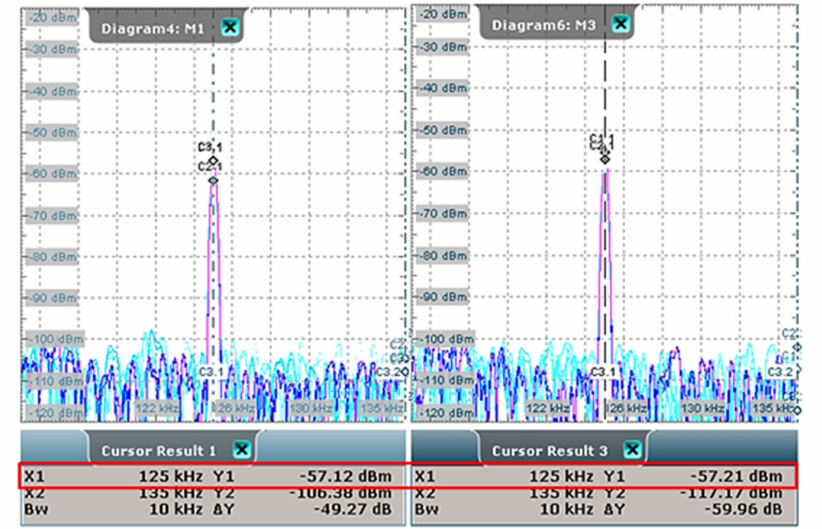
Figure 19. Oscilloscope measurement waveform results for component-level experiments at the center alignment point of the electric vehicle (EV) wireless power transfer (WPT) system.